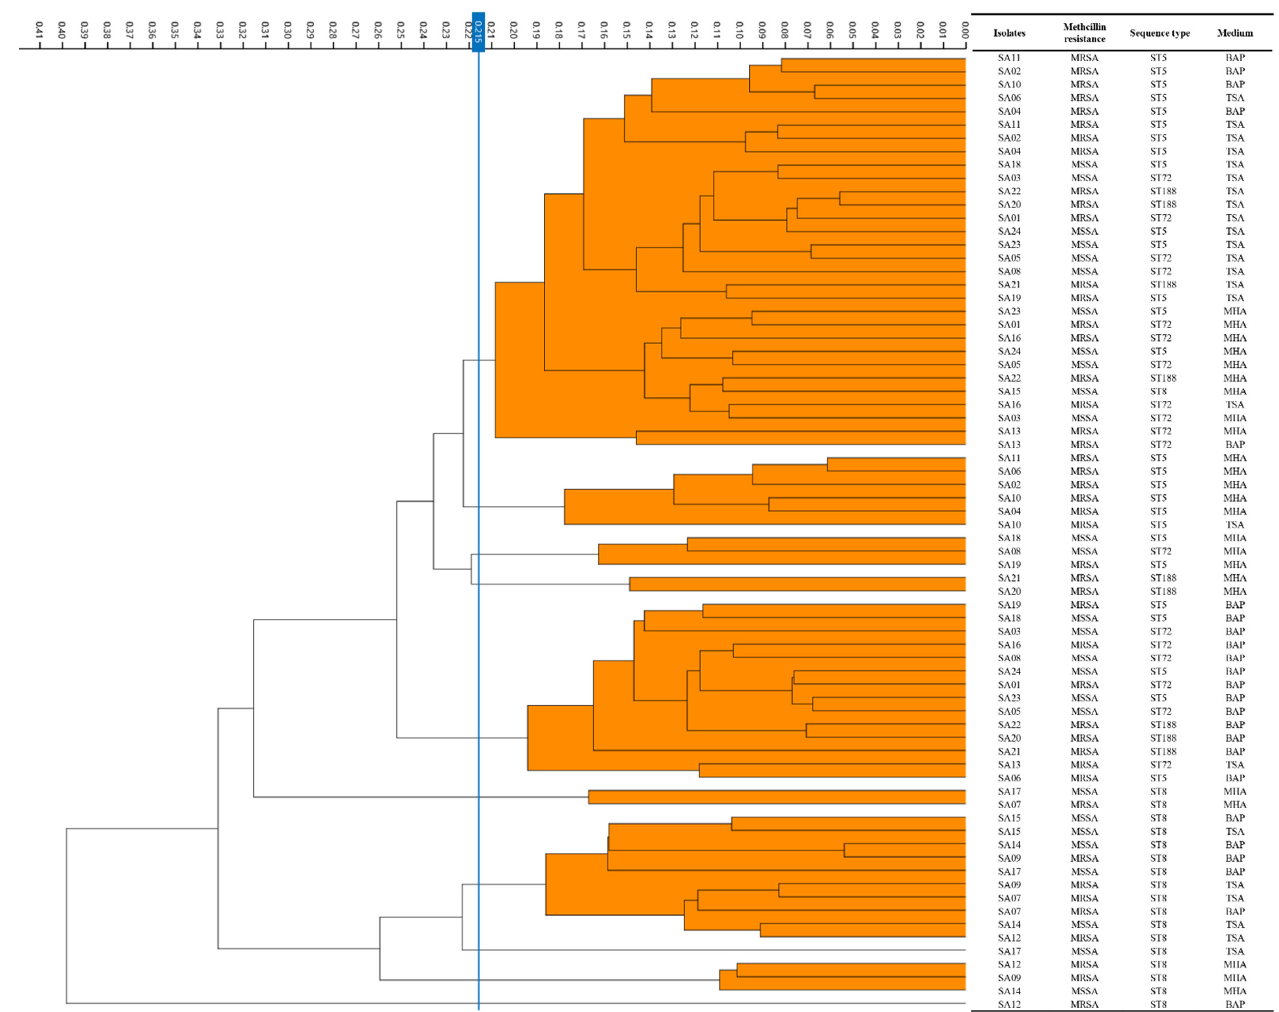
Figure 1. Dendrograms of 24 S. aureus isolates based on the IRBT ® spectra on three media at cut-off of 0.215 with bacterial molecular profiles. The cut-off value automatically generated by the OPUS 7.5 software was indicated with red vertical line. ( A ) 24 spectra of S. aureus isolates on BAP medium by averaging three technical replicates, ( B ) 24 spectra of S. aureus isolates on MHA medium by av- eraging three technical replicates, ( C ) 24 spectra of S. aureus isolates on TSA medium by averaging three technical replicates.